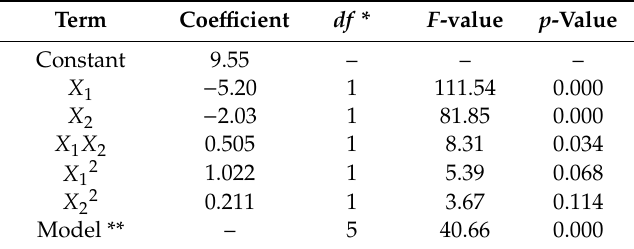
Table 2. Significance of the response surface model and the coe ffi cients for the lag period. Term Coe ffi